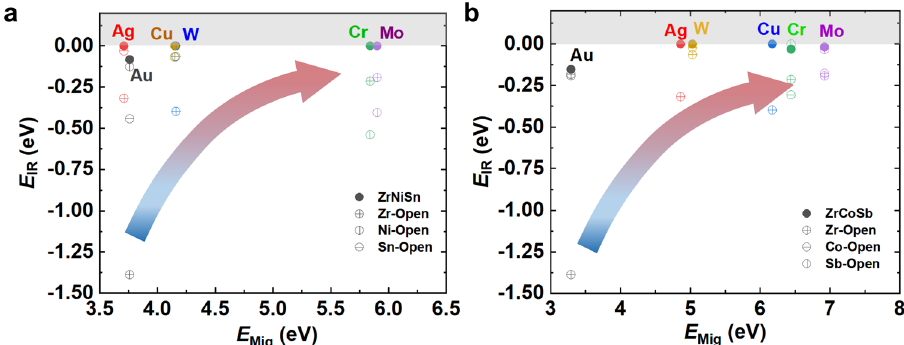
Fig. 2 | Thermodynamicstrategy toscreen barrierlayerelements. The interfacial reactionenergy ( E IR ) and activation energy barrier ( E Mig ) of IBgroup (Cu, Agand Au) and VIB group (Cr, Mo, and W) elements in a ZrNiSn and b ZrCoSb. The arrows suggest the screening strategy for ideal barrier